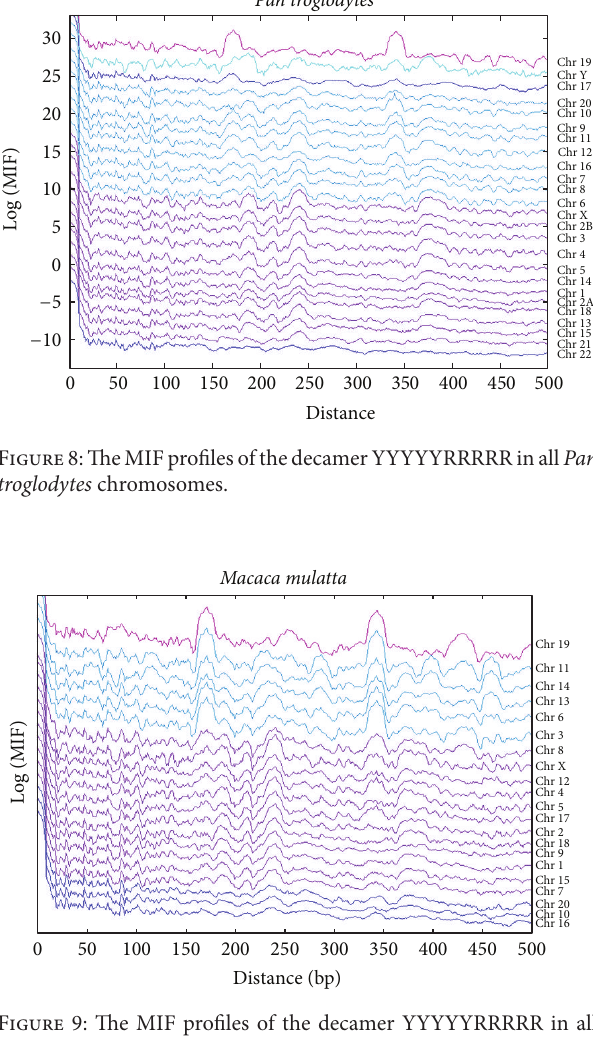
Figure 9: The MIF profiles of the decamer YYYYYRRRRR in all Macaca mulatta chromosomes.